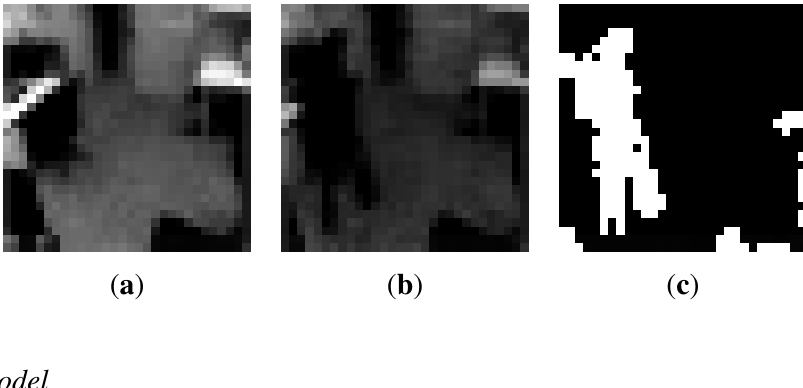
Figure 4. An example ( a ) background image I foreground image F